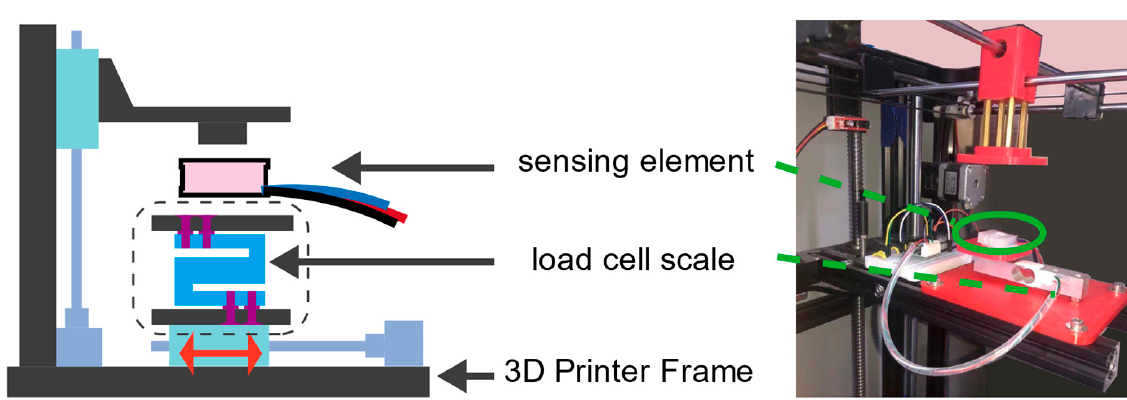
Figure 5. Characteristic analysis system.